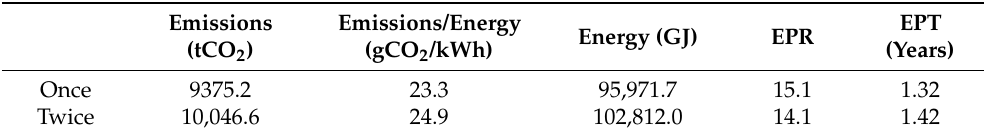
Table 13. CO 2 emissions and energy consumption for the project considering a hub and blades replacement. Emissions Emissions/Energy Energy (GJ) (tCO 2 ) (gCO 2 /kWh) Once